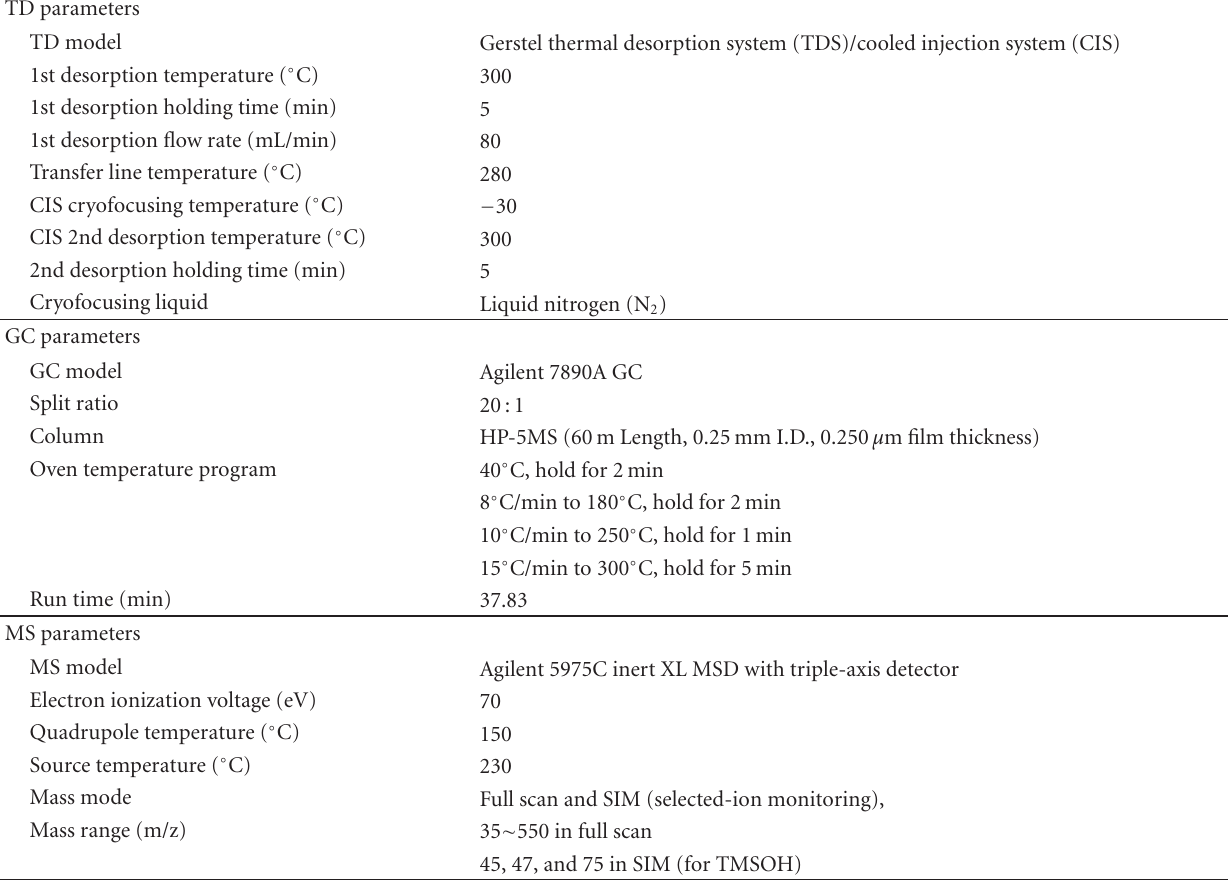
Table 1: Thermal desorption (TD)-GC-MS